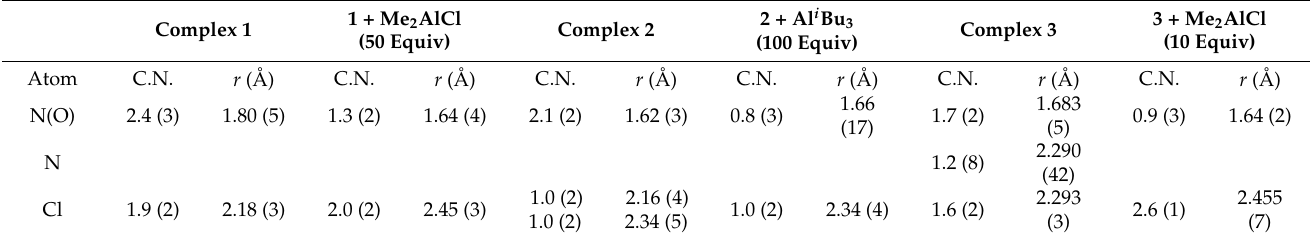
Table 2. Summary of data for V(NAr)Cl 2 (OAr) ( 1 , Ar = 2,6-Me 2 C 6 H 3 ) [37], V(NAr)Cl 2